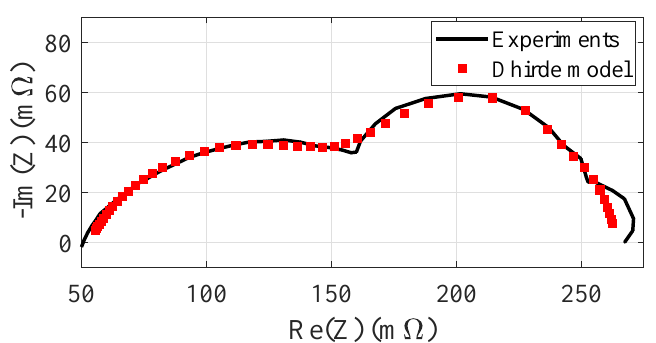
Figure 9. Dataset B. Cathode drying.